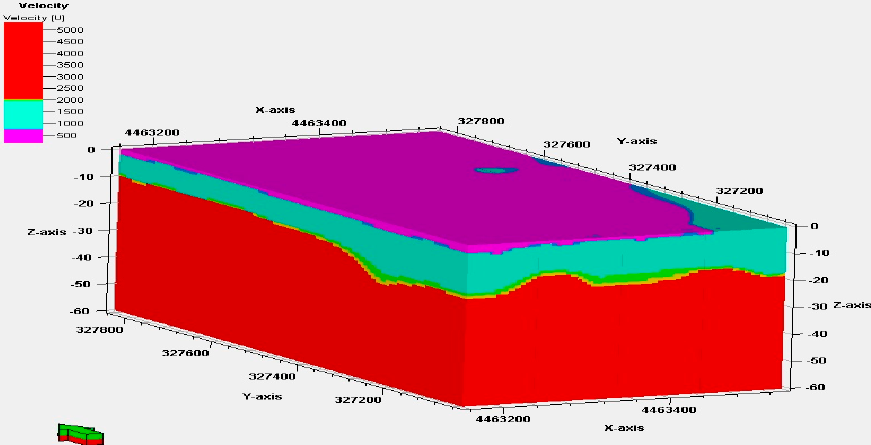
Figure 16. Completed petrophysical model of the seismic velocity attribute. All cells within the grid were assigned a value using the convergent interpolation algorithm. West is indicated by the green arrow.